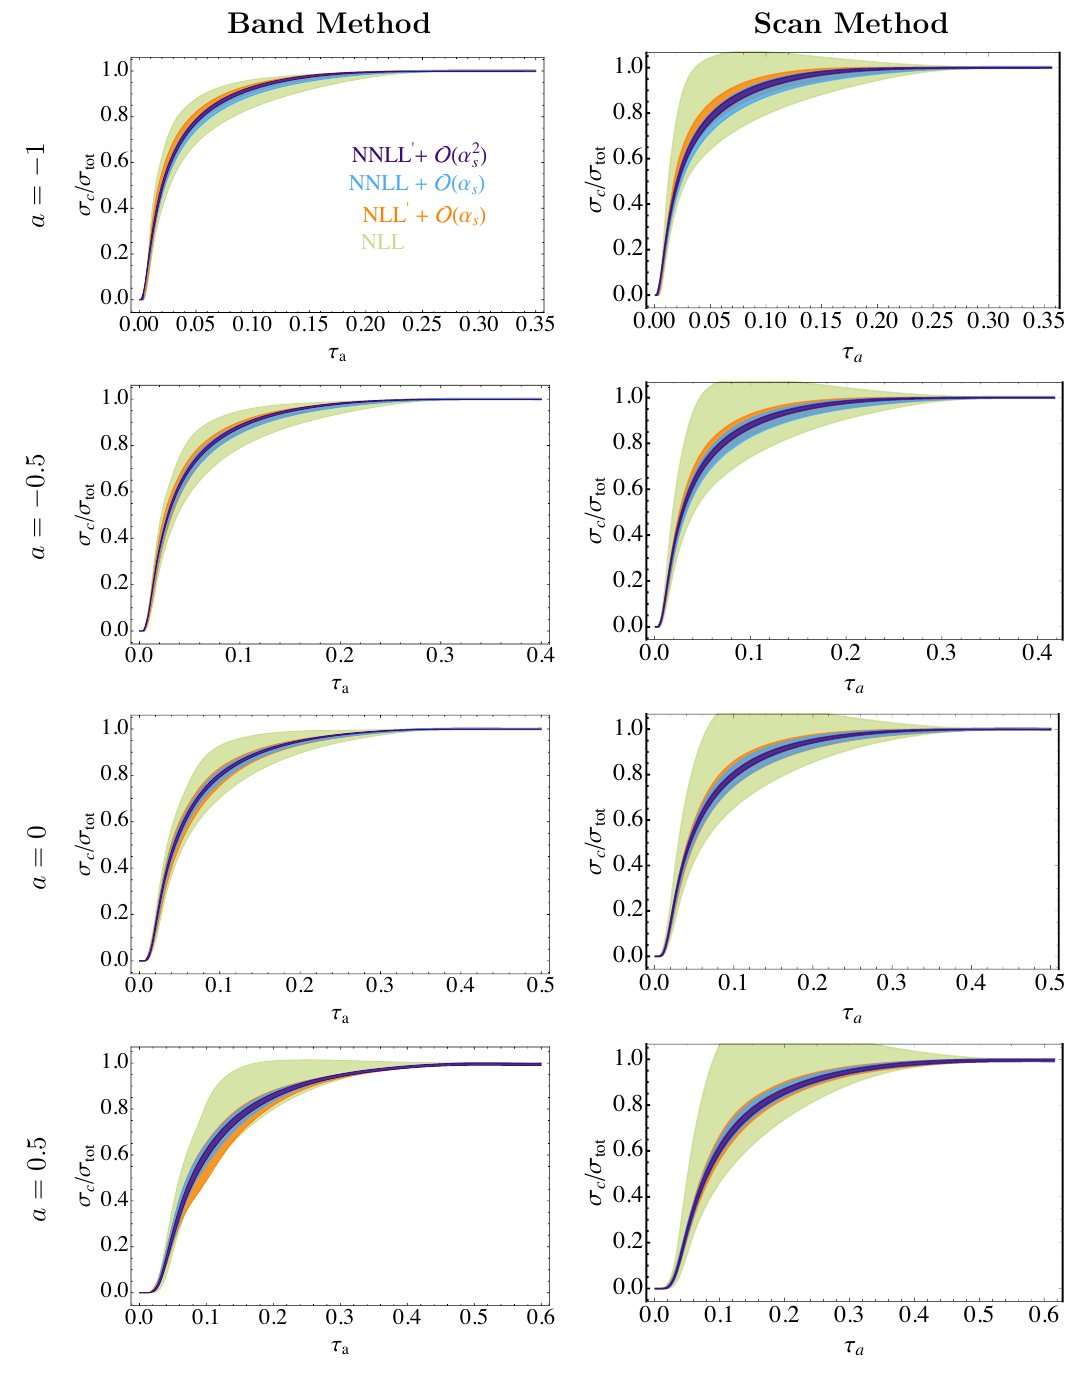
Figure 11 . Integrated angularity distributions for four values of a = Q = m Z at NLL (green), NLL 0 + accuracy, with renormalon subtractions to the corresponding orders. The theoretical uncertainties have been estimated with the band method (left) and the scan method (right) as discussed in section